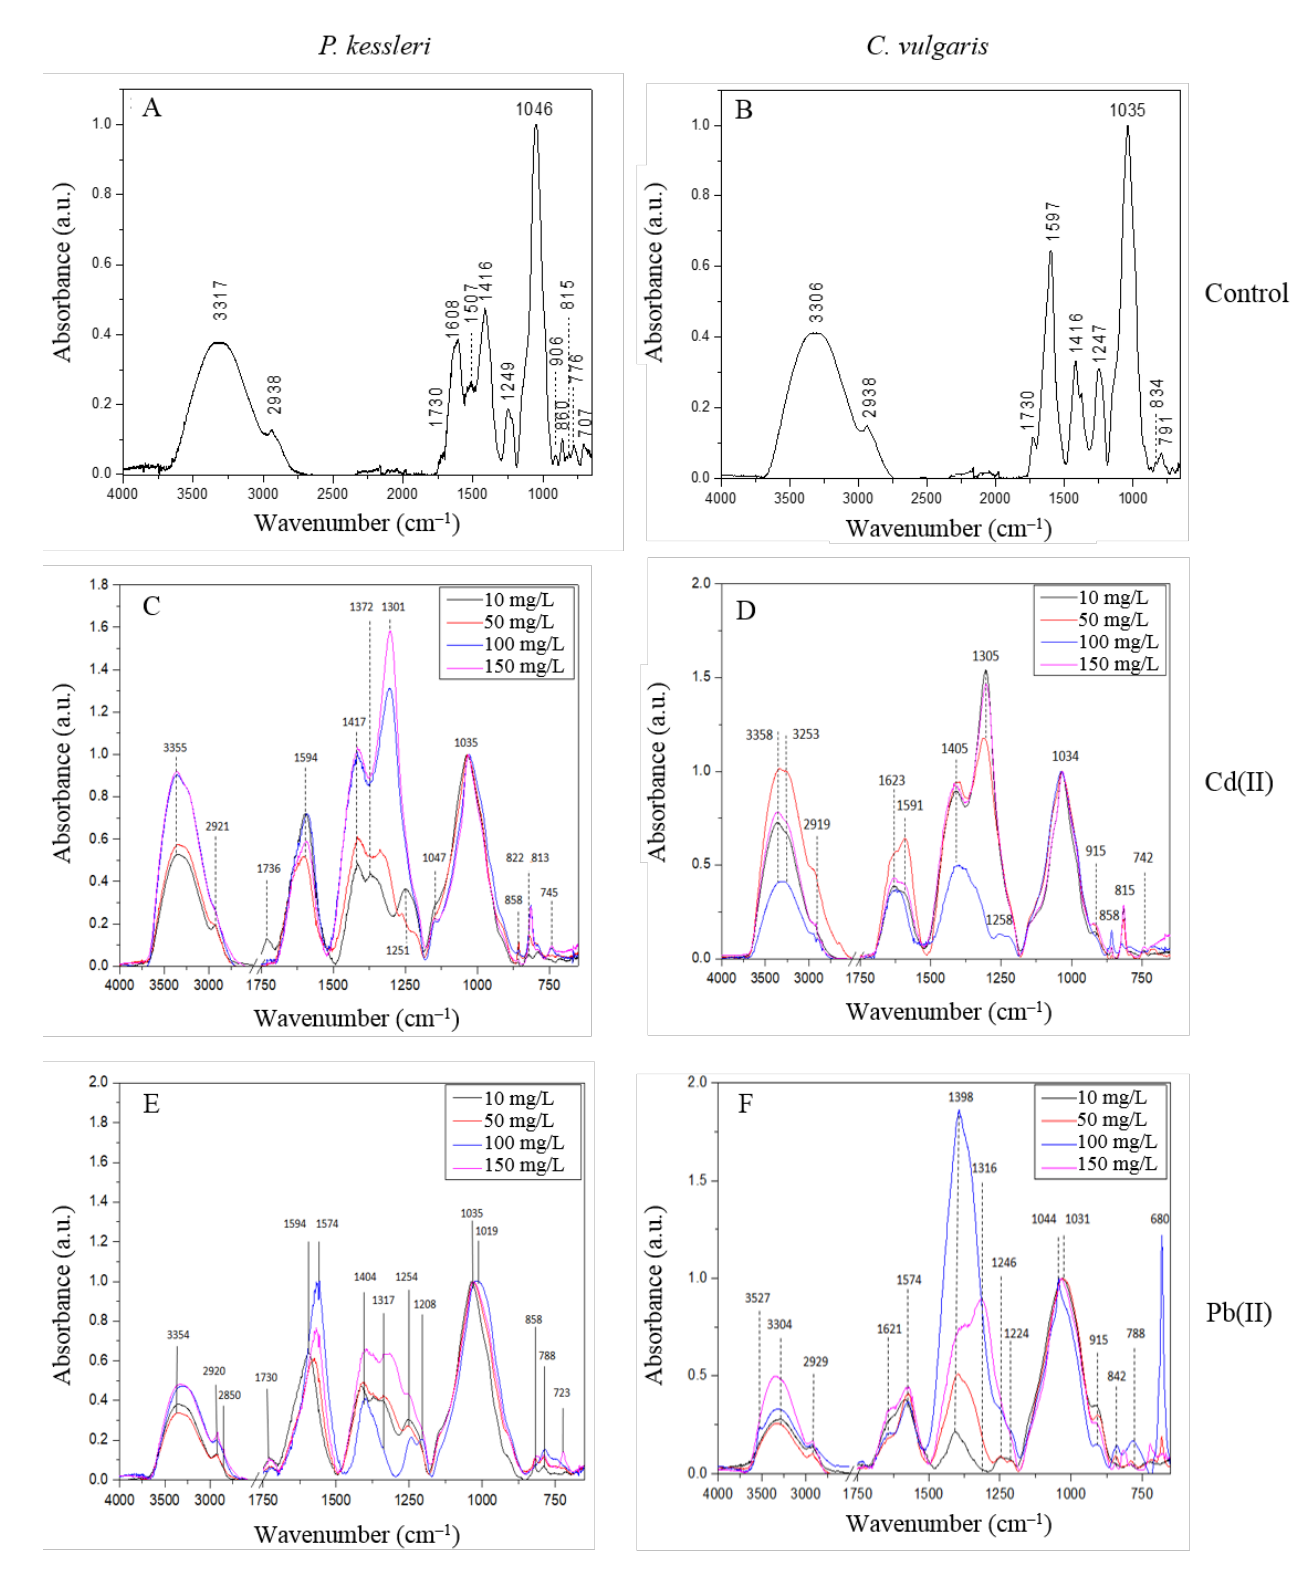
Figure 2. FTIR spectra of EPS from P. kessleri ( A , C , E ) and EPS from C. vulgaris ( B , D , F ) before ( A , B ) after additions of cadmium ( C , D ) and lead ( E , F ) in the range of 3750-650 cm − 1 (the region 2750 – 1750 cm − 1 was removed due to the lack of spectral features).